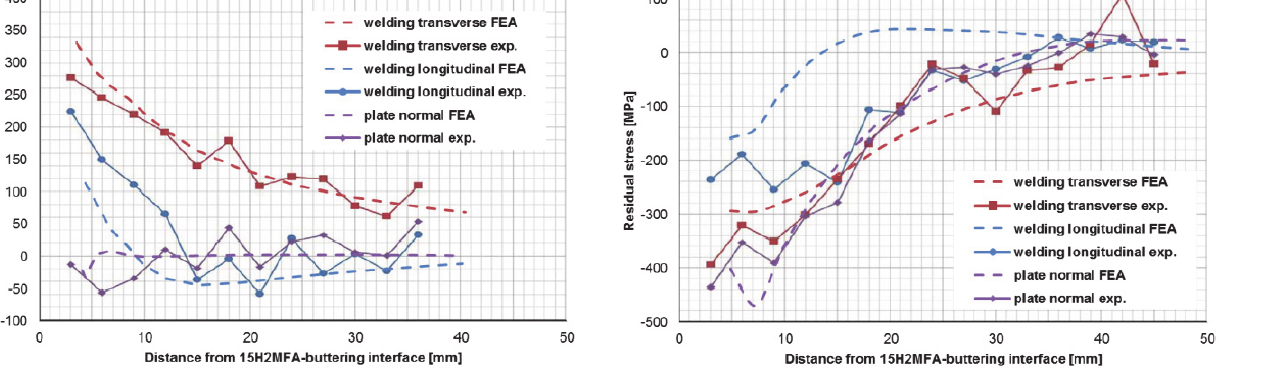
Figure 11: Estimate of residual stresses along a line 3.33 mm from the specimen surface.